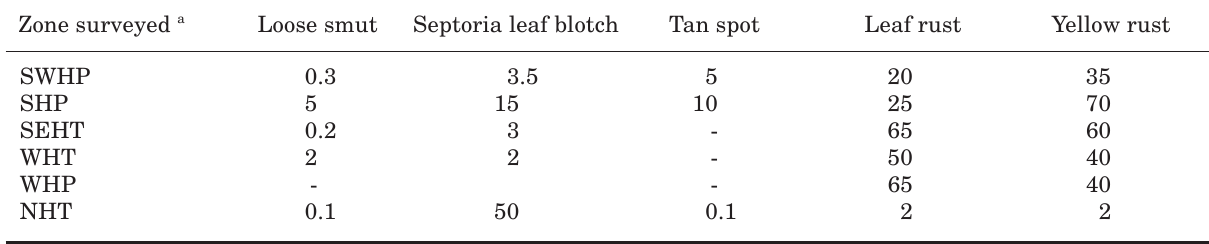
Table 6. Average incidence (%) of wheat diseases in fields in Eritrea in 2001. Zone surveyed a